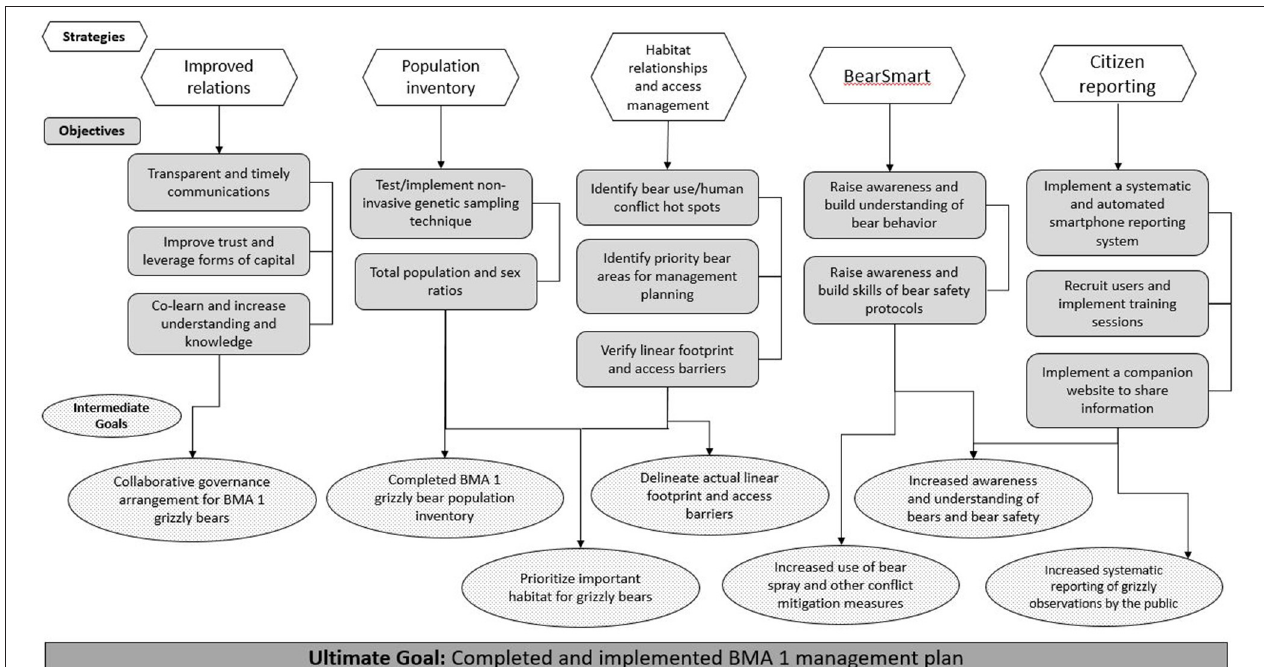
FIGURE 2 | Northwest Grizzly Bear Team’s Theory of Change conceptual